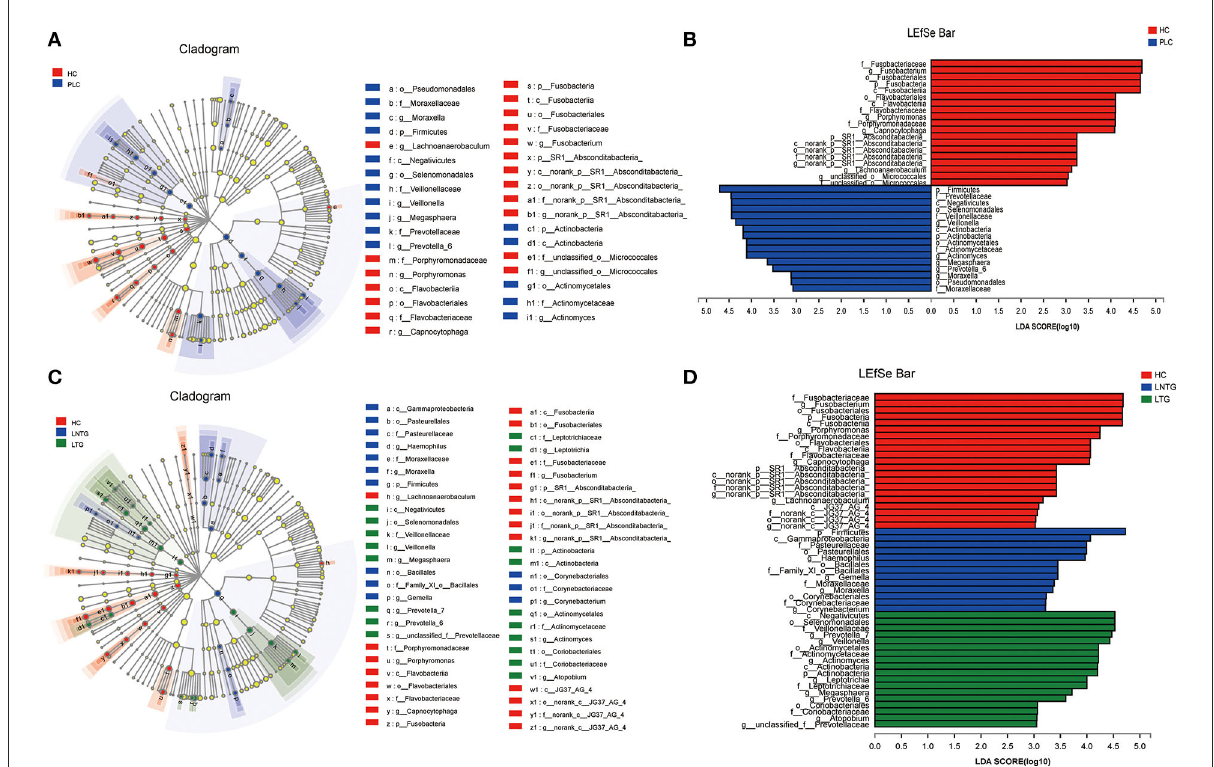
FIGURE4 Differentially abundant bacterial taxa in the tongue-coating microbiota were identified by LDA effect size (LEfSe) analysis. (A,B) Taxonomic cladogram (A) of significant differences and histogram (B) of the LDA scores for PLC (blue) and HC (red) groups. (C,D) Taxonomic cladogram (C) of significant differences and histogram (D) of the LDA scores between HC (red), LTG (green), and LNTG (blue) groups. (PLC represents primary liver cancer, LTG represents liver cancer with thick or greasy coating, LNTG represents liver cancer with non-thick or greasy coating, and HC represents healthy